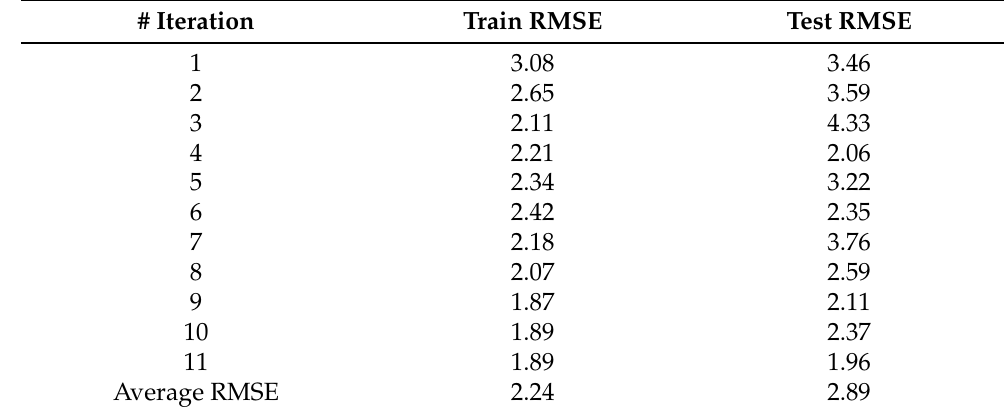
Table 7. Average RMSE for training and test sets at each iteration with blocking time series split.